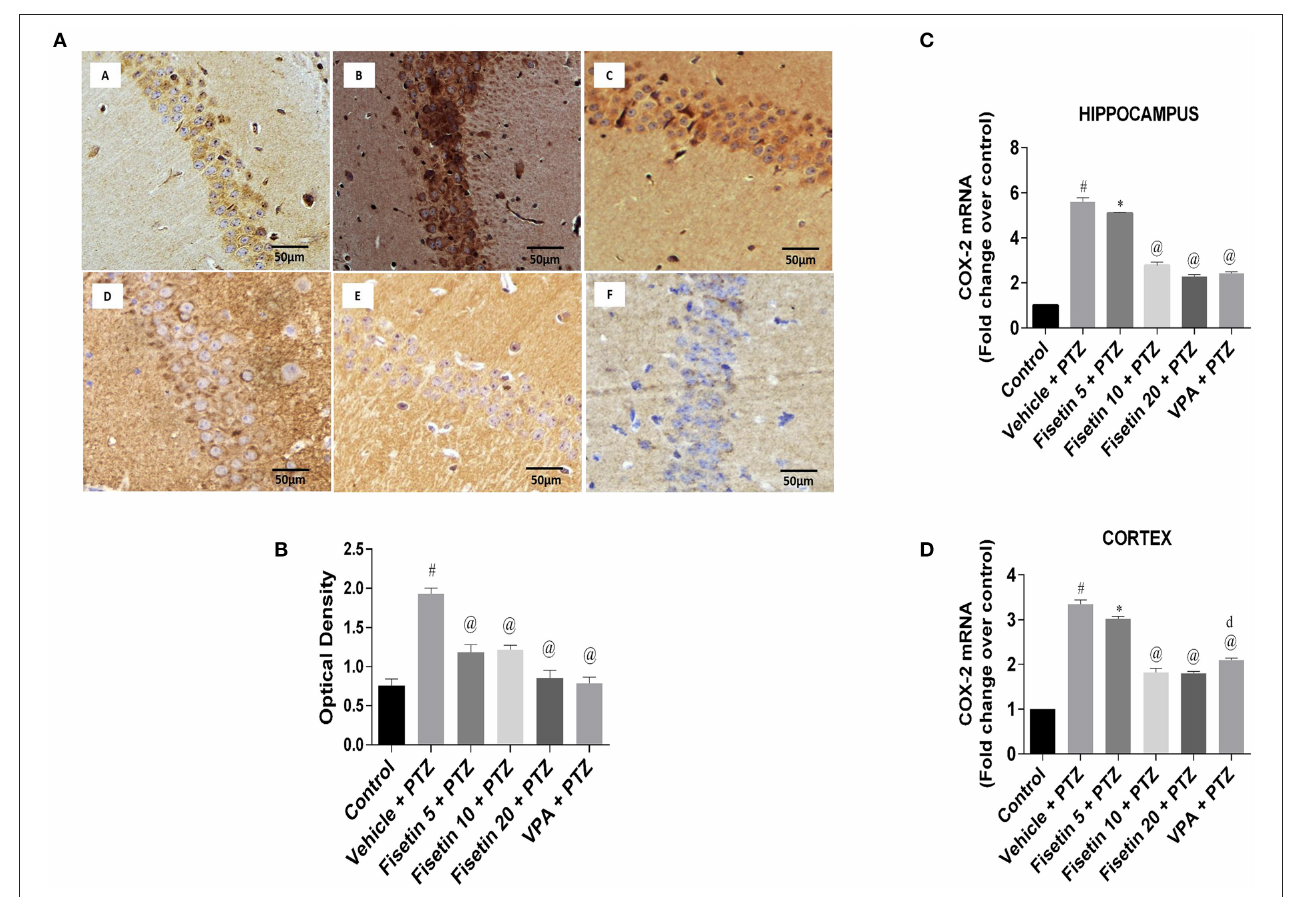
FIGURE 6 | Effect of Fisetin Administration on COX-2 in the Hippocampus and Cortex of Experimental Mice. (A) Photomicrographs of the hippocampus in different groups are shown (40X). (A) Control, (B) vehicle + PTZ, (C) fisetin 5 + PTZ, (D) fisetin 10 + PTZ, (E) fisetin 20 + PTZ, and (F) VPA + PTZ. Fisetin administration resulted in reduced immunoreactivity of COX-2 protein in hippocampal neurons as compared with vehicle + PTZ group. (B) Quantitative estimation of COX-2 immunostaining ( n = 3). (C) mRNA expression of COX-2 in the hippocampus ( n = 5). (D) mRNA expression of COX-2 in the cortex ( n = 5). Data were analyzed by one-way ANOVA followed by Tukey’s multiple comparison test and expressed as mean ± SEM. # p < 0.001 as compared with control group; * p < 0.05 as compared to vehicle + PTZ group; @ p < 0.001 as compared with vehicle + PTZ group, and d p < 0.05 as compared with fisetin 20 + PTZ group.